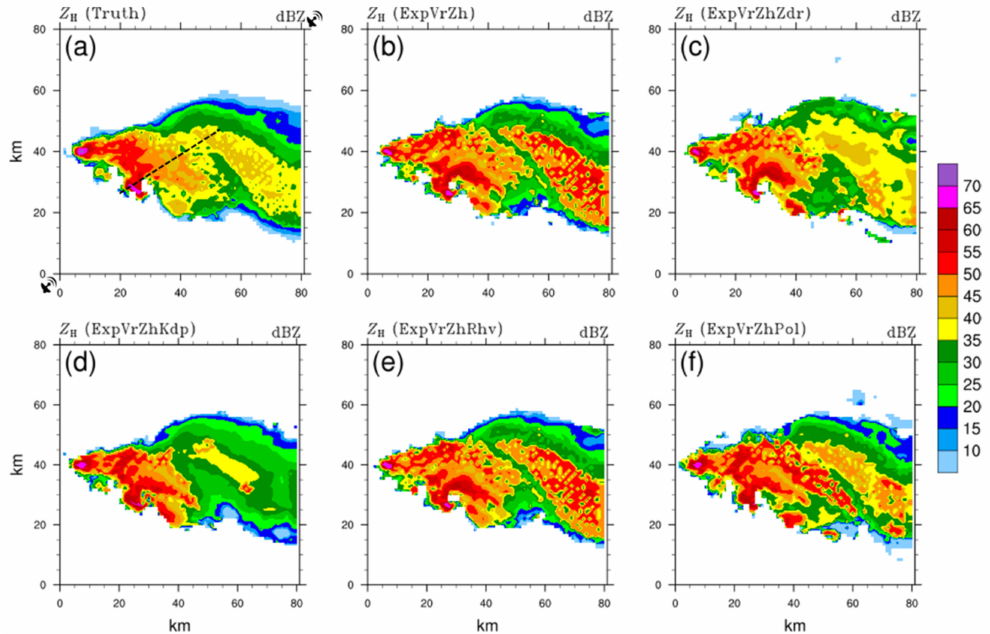
Figure 3. The reflectivity Z H (unit: dBZ) at 1 km altitude at 80 min for ( a ) truth, and analysis fields